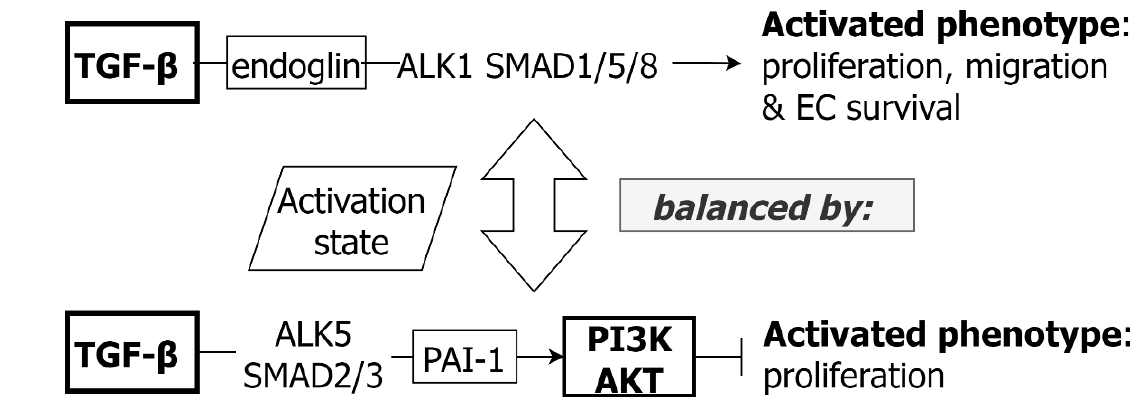
Figure 2. Summary of the mechanisms of TGF- β signaling pathways associated with activation and proliferation of EC. TGF- β activates EC by an endoglin/ALK1/SMAD1/5/8 pathway while EC activation is inhibited by the ALK5/SMAD2/3/PAI-1/PI3K/AKT pathways.